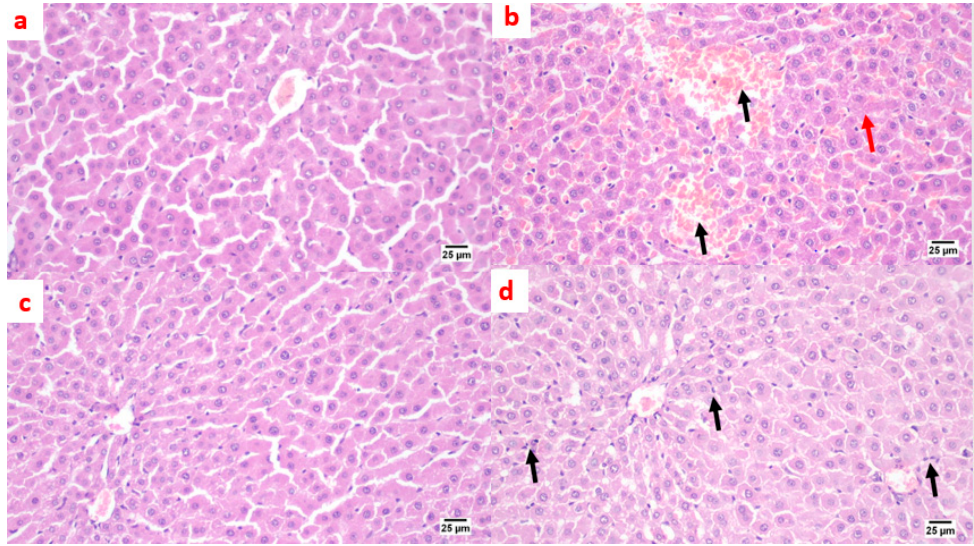
Figure 7. Photomicrographs of rat liver sections stained with H&E showing the effect of 14 days of oral administration of pioglitazone and the synthetic compound against STZ-induced type 2 DM. ( a ) Normal control section (25 µ m). It appears normal histologically. The hepatocytes were arranged in parallel cords radiating from the central vein toward the portal area that contained branches of the portal vein, hepatic artery, and bile duct. On the contrary, ( b ) the positive control group section (25 µ m) shows mononuclear inflammatory cell infiltration at the portal area with a hemorrhage (black arrow), a hyperplastic bile duct, sinusoidal dilatation, and a few necrotic hepatocytes (red arrow). ( c ) The pioglitazone-treated section (25 µ m) shows the hepatic parenchyma was normal, without any detectable histopathological alterations. ( d ) The synthetic compound section (25 µ m) shows a normal hepatic parenchyma with mild hyperplasia in the Kupffer cells, with mononuclear inflammatory cells infiltration at the portal area (black